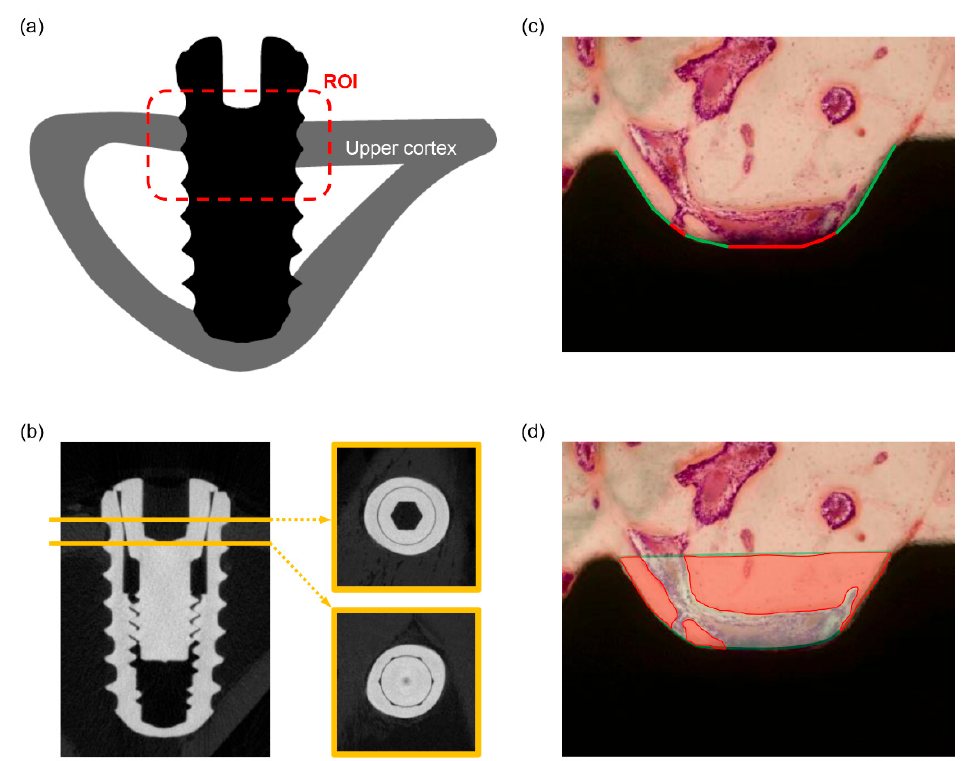
Figure 1. ( a ) The schematic drawing of the region-of-interest (ROI). The ROI was defined as an area within threads engaged in the upper cortical bone (red dot box); ( b ) microcomputed tomography (micro-CT) images for the measurement of the bone-to-implant contact ratio (BIC); ( c ) the bone-to-implant contact ratio (BIC) was calculated by the length of the green line divided by the total length of the well (green and red line); ( d ) the definition of the bone area (BA) was calculated by the area of red color divided by the total area of the well.